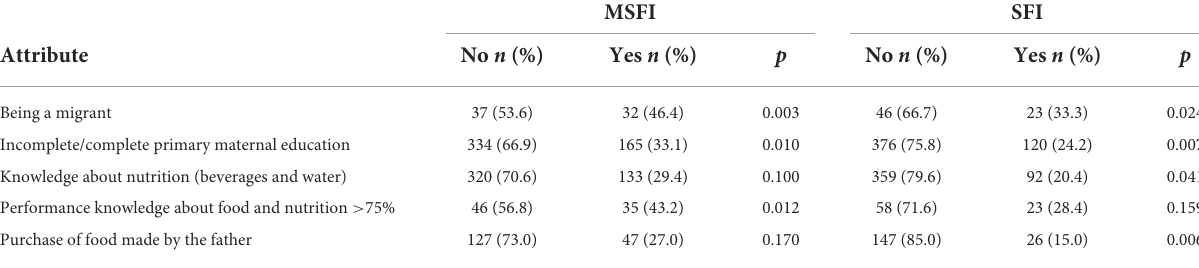
TABLE 4 Associations between the perception of household food insecurity and characteristics of the sample studied, according to perception of Moderate-Severe Food Insecurity (MSFI) and Severe Food Insecurity (SFI) in the